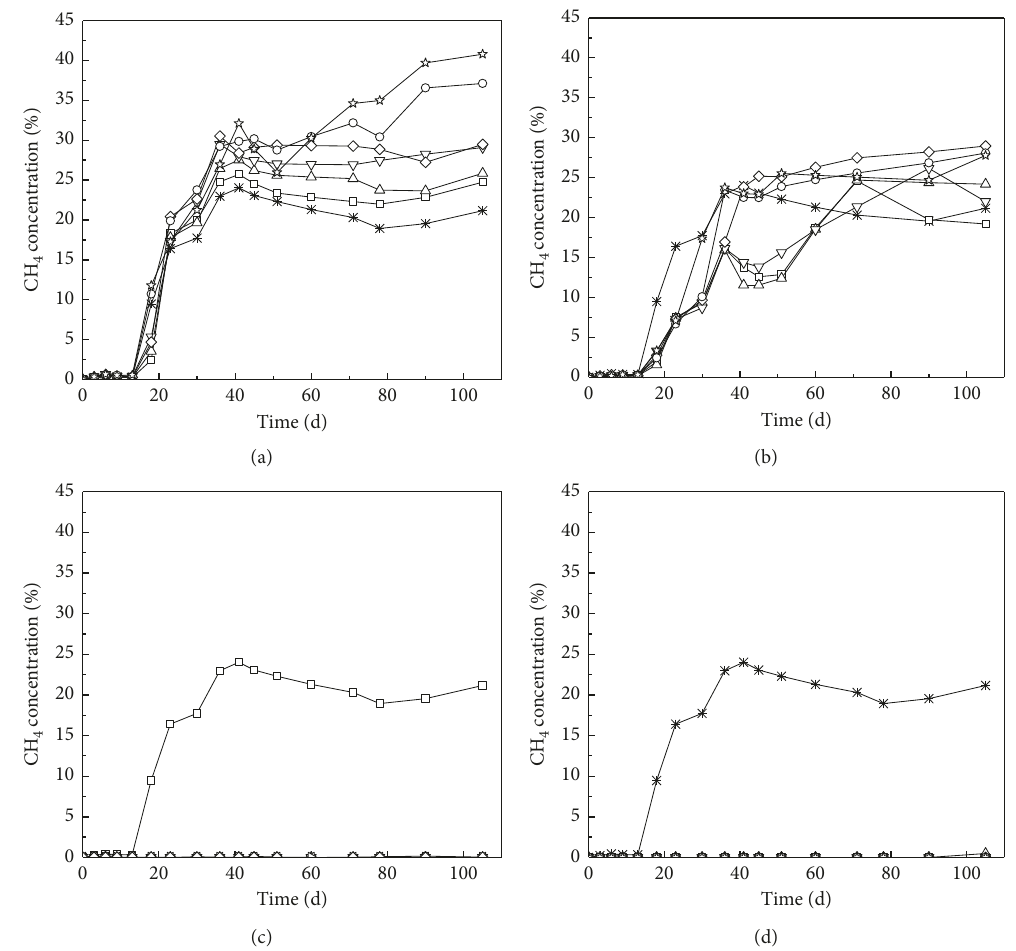
Figure 3: Changes in CH 4 concentration with different iron sources. ( ∗ , Control; □ , 4000mg